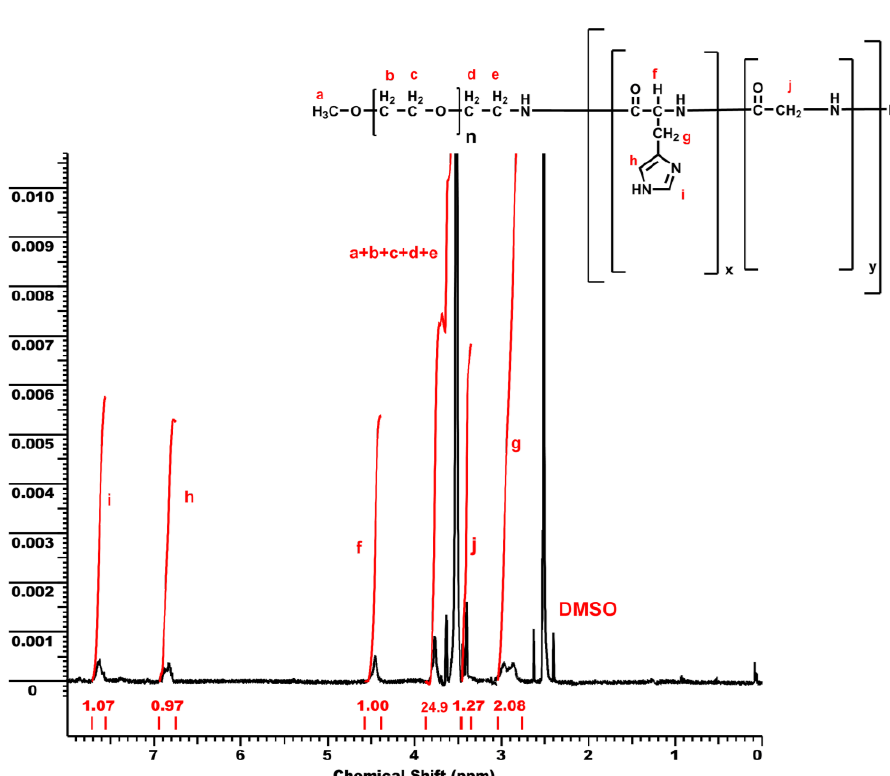
Figure 3. 1 H NMR spectrum of m -PEO- b -poly(His- co -Gly) with 40% of glycine to histidine molar ratio.